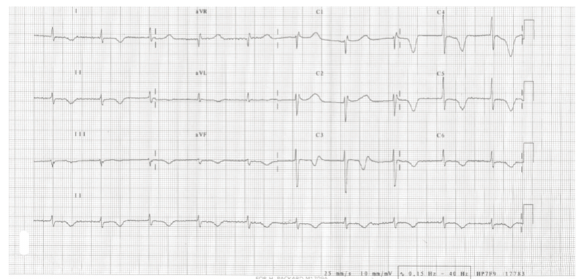
Figure 3: ECG showed bradyarrhythmia, a HR of 48 beats/min, QTc interval prolongation (610ms), and deep inverted T